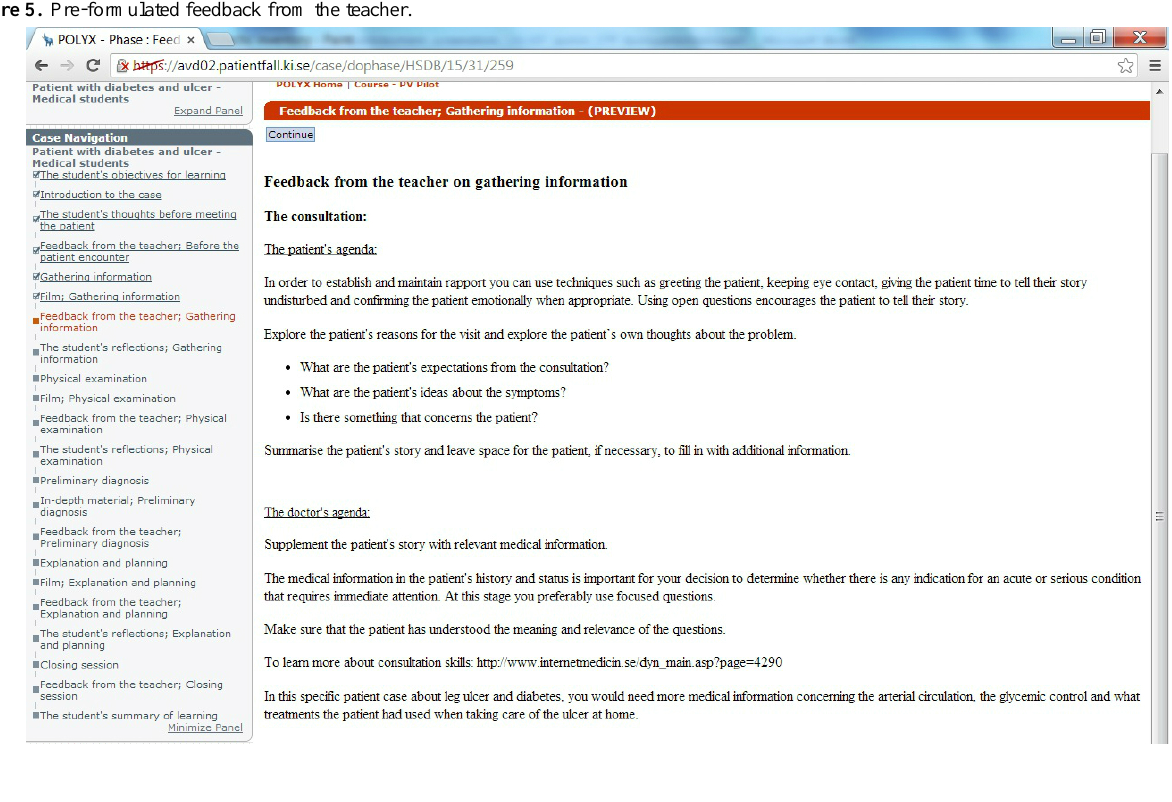
Figure 5. Pre-formulated feedback from the